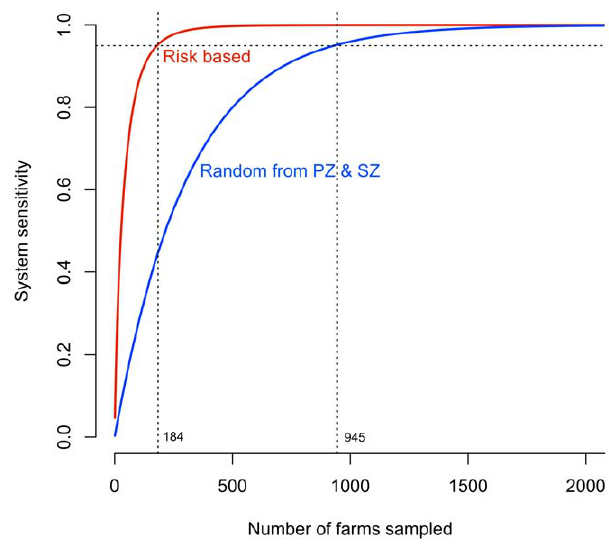
Figure 2. Performance of random and risk-targeted sampling. Comparison of system sensitivity (SSe) of random sampling from the protection (PZ) and surveillance zones (SZ), a 10 Km buffer around designated infected premises (blue line) and risk-targeted sampling (red line). Horizontal dashed line is at 95% system sensitivity (SSe), the conventional target for region level post-epidemic surveillance. The vertical lines dotted lines show corresponding sample sizes required to achieve 95% SSe for the two